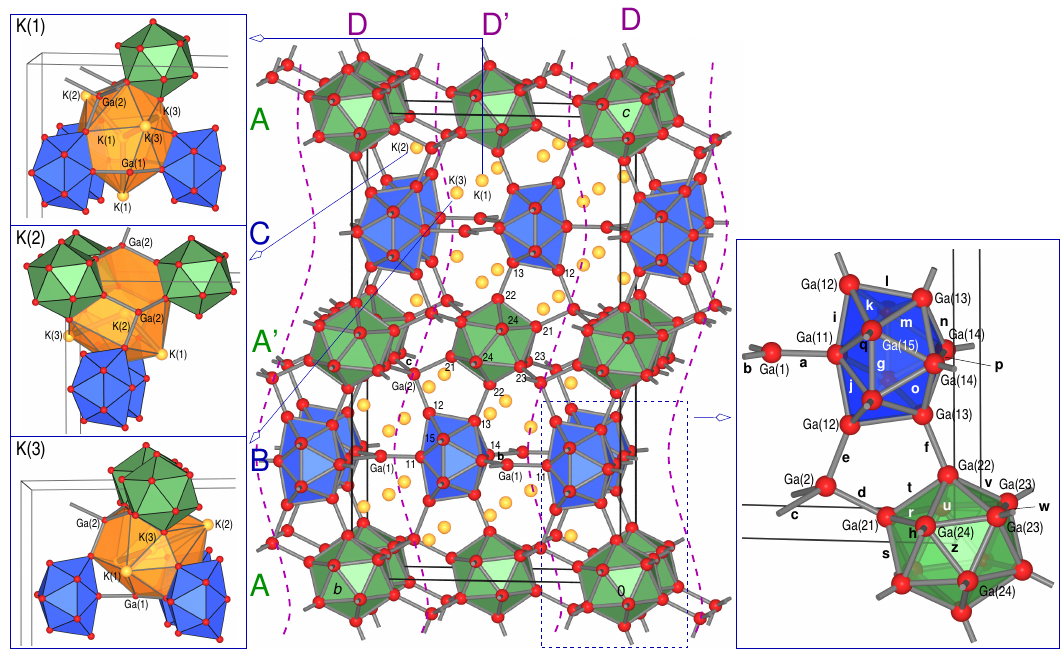
Figure 2. Crystal structure of K Perspective view of the unit cell; Right: Cutout of the polyanion with the atom and bond labeling (red spheres: Ga; yellow spheres: K; green polyhedra: [Ga yellow polyhedra: K + CCPs; cf. Tables 7 and 8 for bond